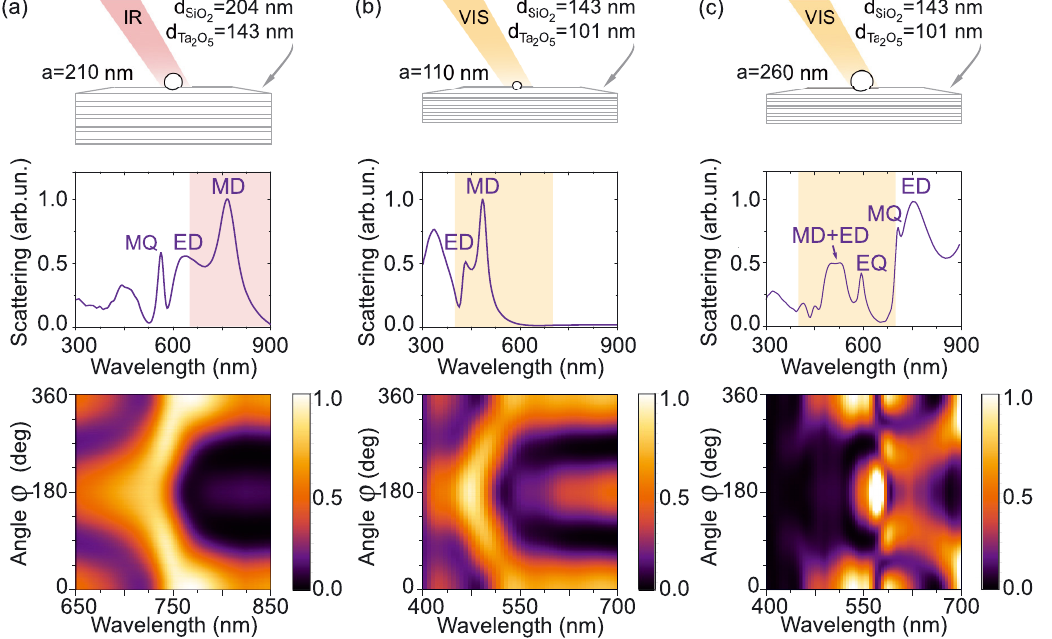
Figure 4: Schemes of 3 simulation cases (up row), their scattering cross-sections (middle row) and efficiency of Bloch surface wave (BSW) excitation (down row): IR is red and infrared spectral range; VIS is visible spectral range; ED is electric dipole resonance; MD is magnetic dipole resonance; EQ is electric quadrupole resonance; MQ is magnetic quadrupole